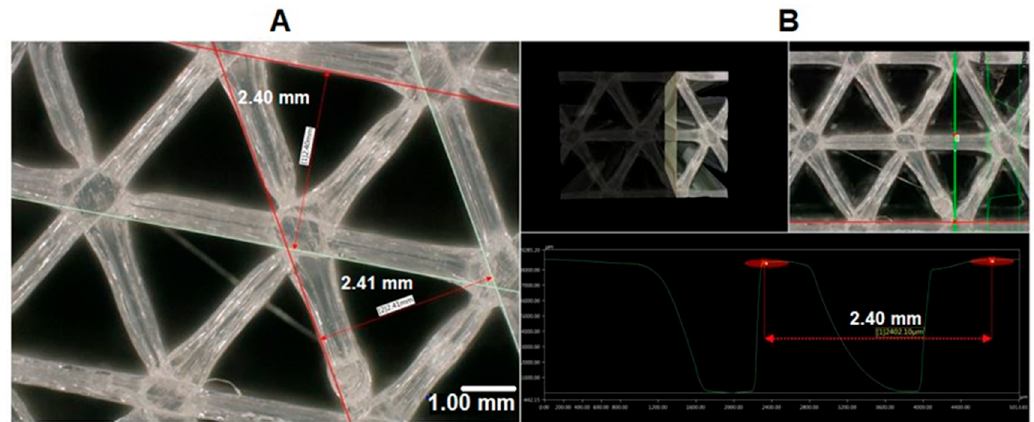
Figure 7. ( A ) Microscopic picture from top view of the 3D-printed sample with 2.4 mm ILD at the 100 × magnification setting. ( B ) 3D profile of the 3D-printed sample with 2.4 mm ILD at the 100 × magnification setting.